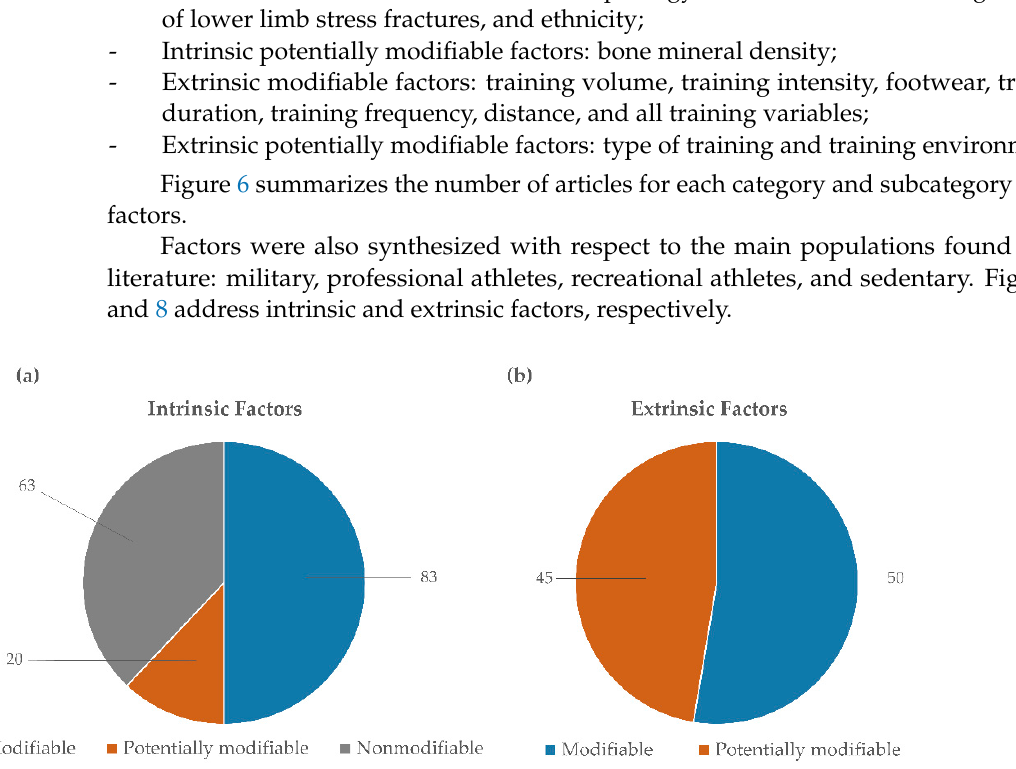
Figure 6. Pie charts illustrating intrinsic ( a ) and extrinsic ( b ) risk factors, and further categorization into modifiable, nonmodifiable, and potentially modifiable factors according to the number of occurrences in the articles. Factors were also synthesized with respect to the main populations found in the lit- erature: military, professional athletes, recreational athletes, and sedentary. Figures 7 and 8 address intrinsic and extrinsic factors, respectively.